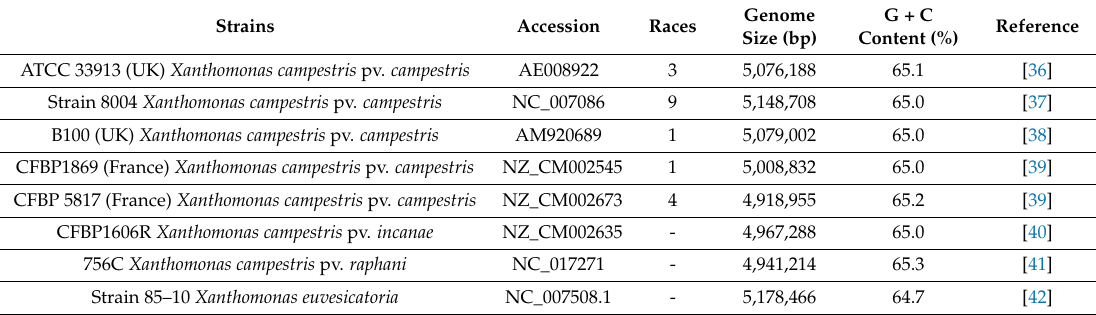
Table 1. Published whole genome sequences of Xcc races and Xc pathovars with accession number, genome size and GC content. Strains Accession Races